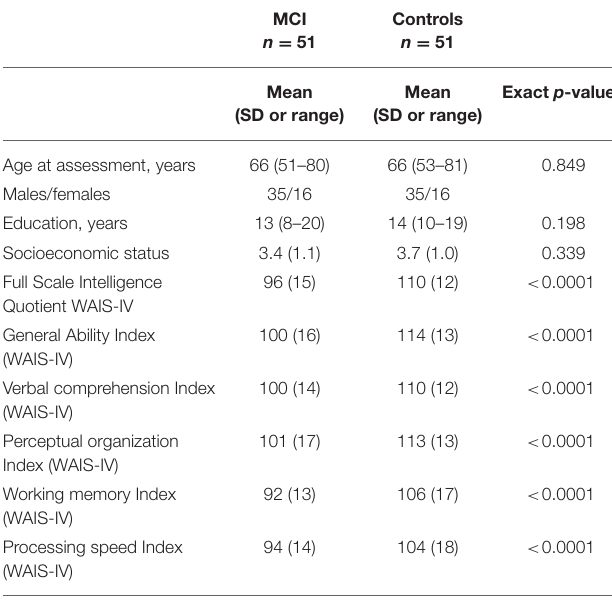
TABLE 1 | Clinical characteristics and cognitive scores in patients with MCI ( n = 51) and controls ( n =